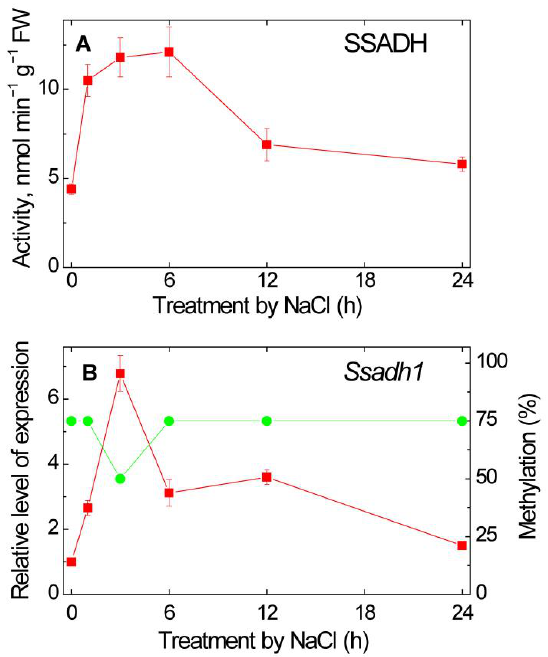
Figure 1. Succinic semialdehyde dehydrogenase (SSADH) activity ( A ), and expression (red squares) and promoter methylation (green circles) of the Ssadh1 gene ( B ) after the transfer of maize seedlings in 150 mM NaCl. The data on activity and expression represent the means of three biological repeats ± SD. The control (untreated) did not exhibit statistically significant changes in the variation level. 2.2. Effect of Salt Stress on SDH Activity and on the Mitochondrial Succinate Oxidation